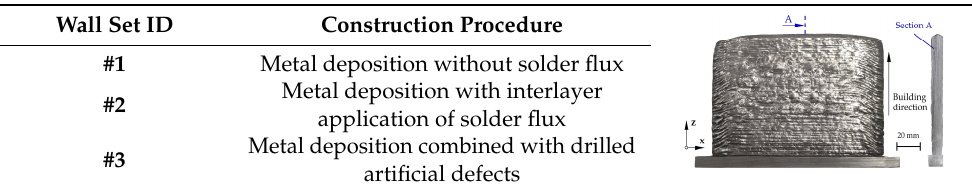
Table 3. Construction procedures for the three different sets of WAAM aluminum straight walls used in the experimental tests.